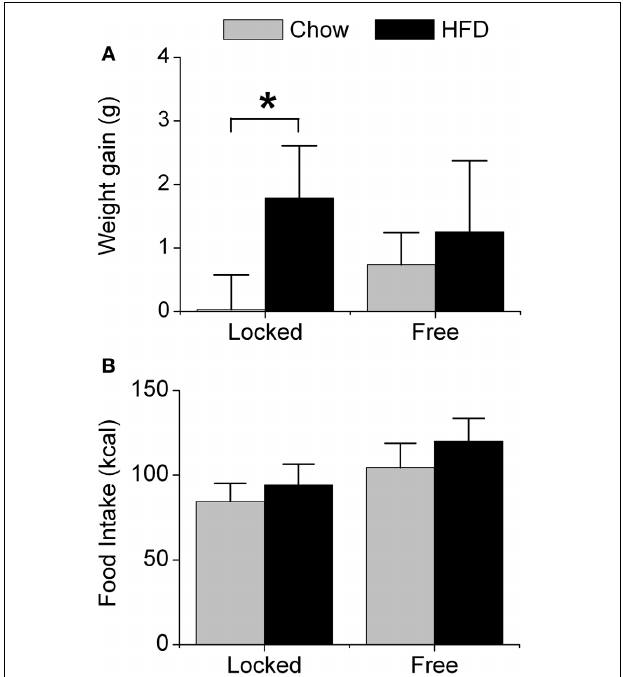
FIGURE 1 | Acute effect of wheel-running activity on body weight and food intake. Male heterozygous PER2::LUC mice were single-housed at 7 weeks old in cages with either locked or freely rotating running wheels and provided with chow ad libitum for 1 week. At 8 weeks old, mice were provided with fresh chow (gray) or high-fat diet (HFD; black) for 1 week. The mean ( ± SD ) weight gain ( A ; grams) and food intake ( B ; kcal metabolizable energy) were determined during 1 week of chow or HFD feeding. There was a main effect of diet [ F ( 1 , 32 ) = 14 . 93, p < 0 . 001] and a significant interaction between wheel and diet [ F ( 1 , 32 ) = 4 . 39, p = 0 . 04] on body weight gain. Mice with locked wheels consuming HFD gained more weight than chow-fed mice ( ∗ p < 0 . 001). There were significant main effects of wheel [ F ( 1 , 32 ) = 27 . 15, p < 0 . 001] and diet [ F ( 1 , 32 ) = 8 . 28, p < 0 . 01] on food intake. Locked/chow n = 7; Locked/HFD n = 12; Free/chow n = 6; Free/HFD n = 11.